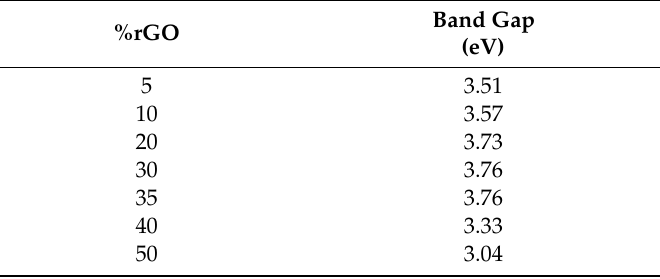
Table 2. Band gap energies of rGO / Bi nanocomposites.